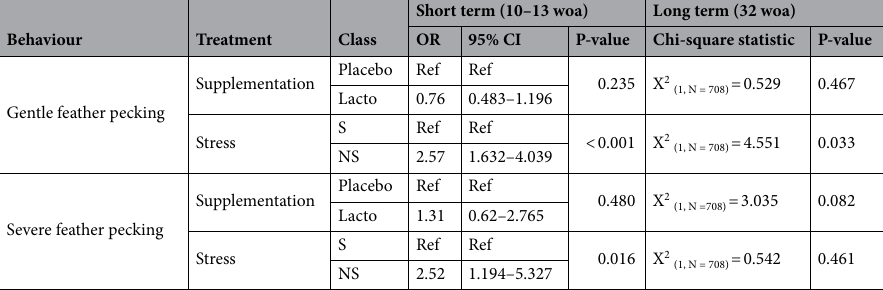
Table 1. Odds Ratio (OR) estimates and 95% Confidence Interval (CI), and Chi-square statistics of the short-term (between 10 and 13 weeks of age [woa]) and long-term (32 woa) feather-pecking behaviour in laying hens. OR > 1 indicates that birds are more likely to be classified as a feather pecker, whereas an OR < 1 indicates that birds were less likely to be classified as a feather pecker (Feather Pecker: bird that displayed gentle or severe feather pecking at least once between 10–13 woa or 32 woa). Placebo = water supplementation, Lacto = L. rhamnosus, S = stressed, NS = non-stressed, Ref = Reference value, n of birds at 10–13 woa: Placebo = 178, Lacto = 176, S = 177, NS = 177 and n of birds at 32 woa: Placebo = 154, Lacto = 157, S = 156, NS =